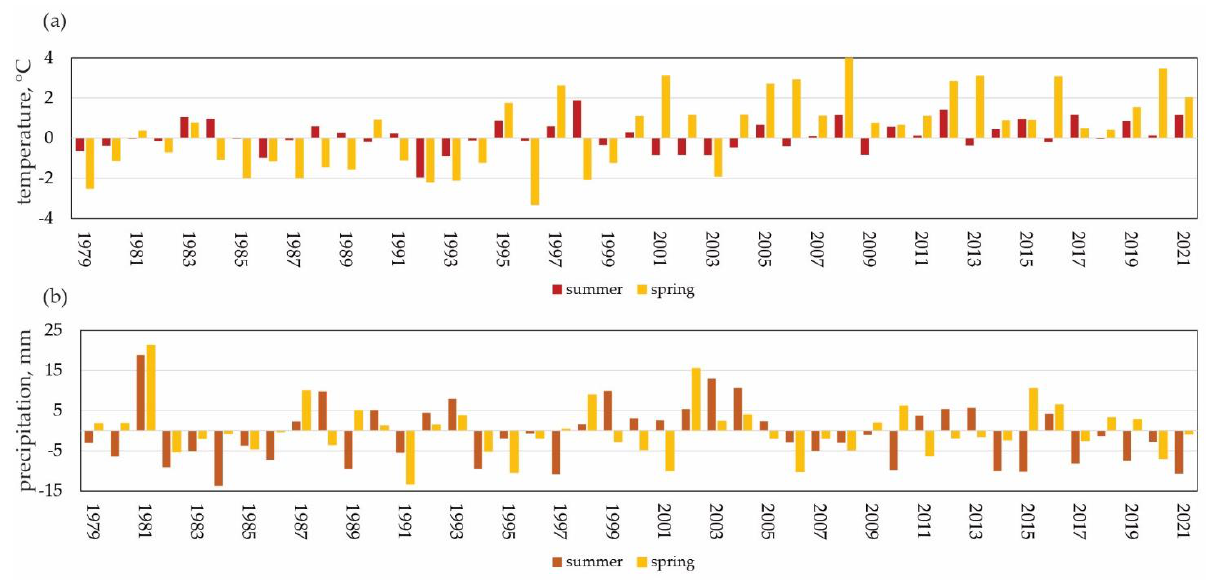
Figure 3. The temporal variability of annual anomalies of the air temperature, °C ( a ), and precipitation, mm ( b ), on the territory of Kazakhstan in spring (MAM) and summer (JJA) periods over 1979 – 2021.